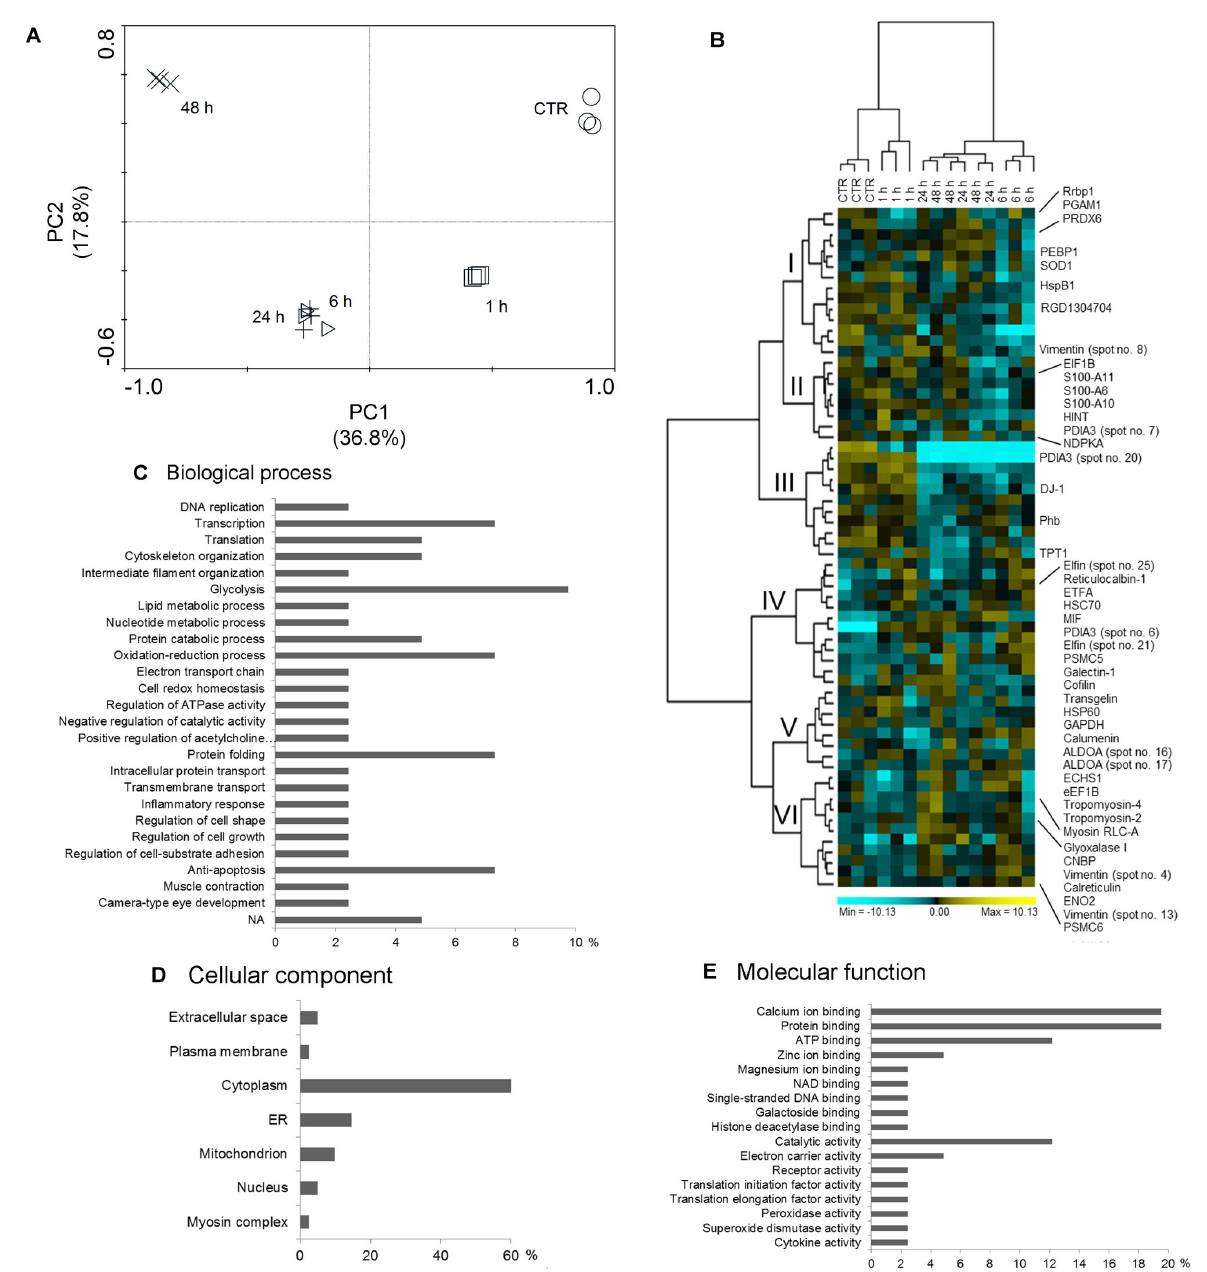
Figure 2. Multivariate analysis of proteomic data. ( A ) PCA plot of the protein spot maps of cardiomyocytes untreated (DMSO vehicle control; circles) and after exposure to SF for 1 (triangles), 6 (squares), 24 (diamonds) and 48 h (crosses). Log-transformed data were used. Each symbol represents a 2-DE gel from each treatment series. First and second ordination axes are plotted explaining 36.8 and 17.8% of the overall variance in the dataset, respectively. ( B ) Two-way hierarchical clustering of the 64 differentially expressed protein spots between SF-treated cardiomyocytes and DMSO vehicle control. Pearson's dissimilarity as distance measure and Ward's method for linkage analysis were used. Log ratios are colour coded as indicated. Names of the 2 identified protein spots are shown on the right (see Table S1). A larger version of this image with gene names and spot IDs in brackets is available as Figure S1. ( C - E ) Functional categories by Gene Ontology (GO) analysis of the identified proteins. Classification was performed according to keyword categories [( C ) biological process, ( D ) cellular component, ( E ) molecular function]. When proteins were associated with more than one functional category, one GO term was chosen arbitrarily. NA, not available. ER, endoplasmic reticulum. doi: 10.1371/journal.pone.0083283.g002 PLOS ONE |